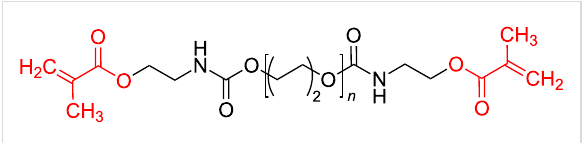
Figure 13: Structure of the photopolymerizable urethane dimethacry- late (PTHF-UDMA).